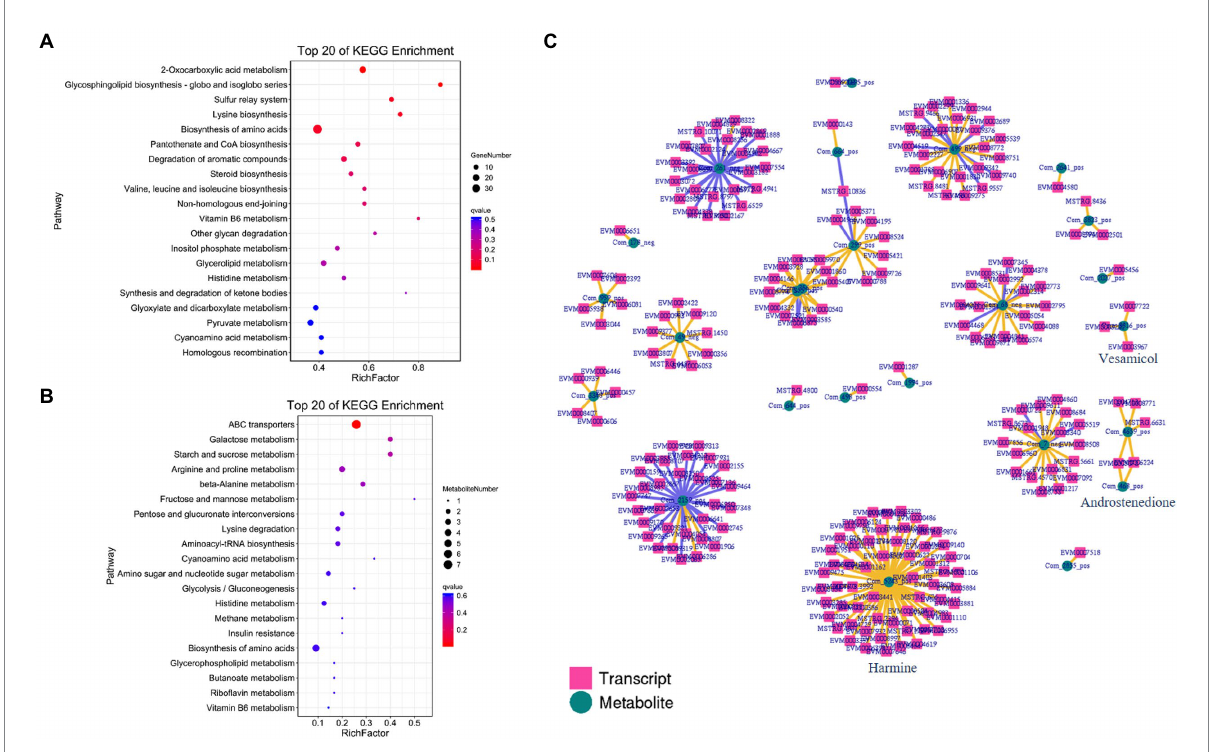
FIGURE 5 Correlation analysis between mycelial metabolites and transcriptomics (M16d_2 vs. M16d_0). (A) KEGG DEGs in M16d_2 vs. M16d_0. (B) KEGG differential metabolites in M16d_2 vs. M16d_0. (C) Pearson correlation coefficient calculation of DEGs and differential